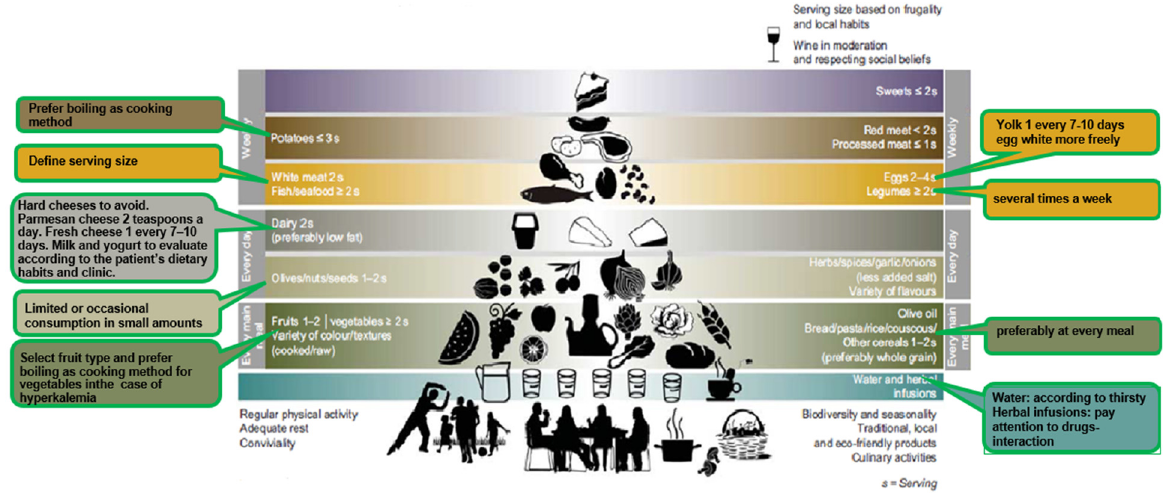
Figure 1. The new Mediterranean Diet Pyramid, with the addition of boxes (with green outline) on the right and the left side of the pyramid, reporting the main changes to adapt the Mediterranean diet to CKD, leading to the Mediterranean Renal Diet. Table 1 shows more details. Modified from Bach ‐ Faig A et al.